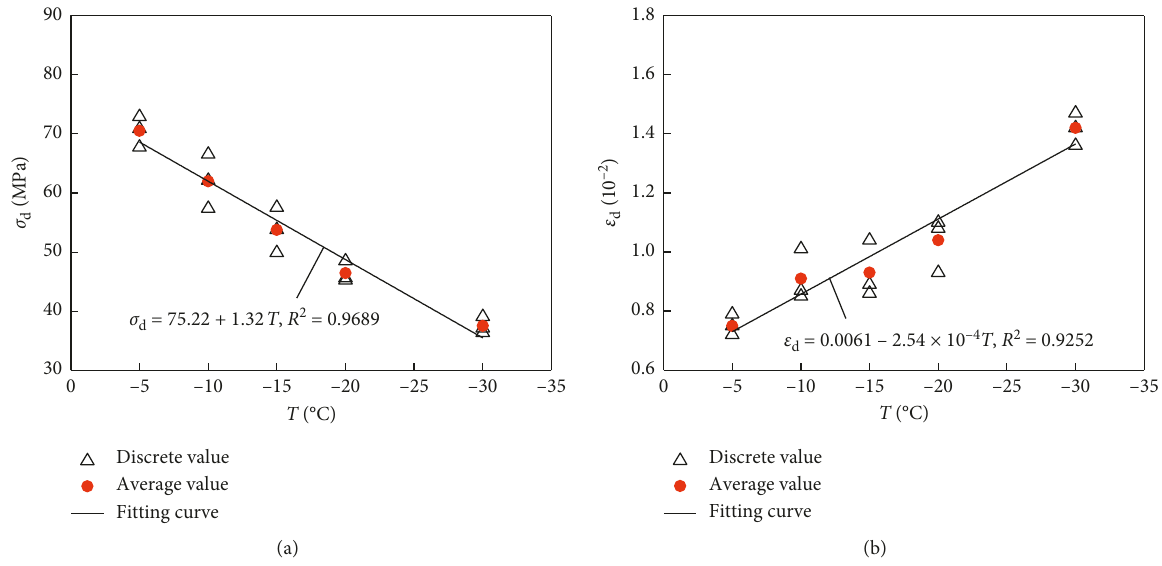
Figure 12: Dynamic peak strength ( σ d ) and peak strain ( ε d ) change curve with F-T temperatures ( T